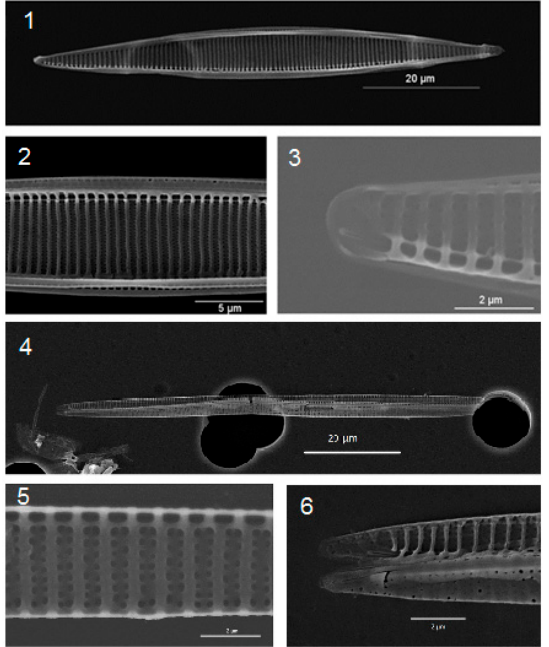
Figure 3. ( 1 – 3 ) Scanning electron micrographs of Pseudo-nitzschia australis . Note the: ( 1 ) apically asymmetric valve; ( 2,3 ) details of the rounded poroids arranged in two striae, the absence of central interspace. ( 4 – 6 ) Scanning electron micrographs of P. pungens . Note the: ( 4 ) Linear to lanceolate valves ( 5 , 6 ) 2 rows of poroids in contact with interstriae and arranges in opposite sites. Scale bar: ( 1 ) 20 μ m, ( 2 ) 5 μ m, ( 3 ) 2 μ m, ( 4 ) 20 μ m, ( 5 ) 2 μ m, and ( 6 ) 2 μ m.